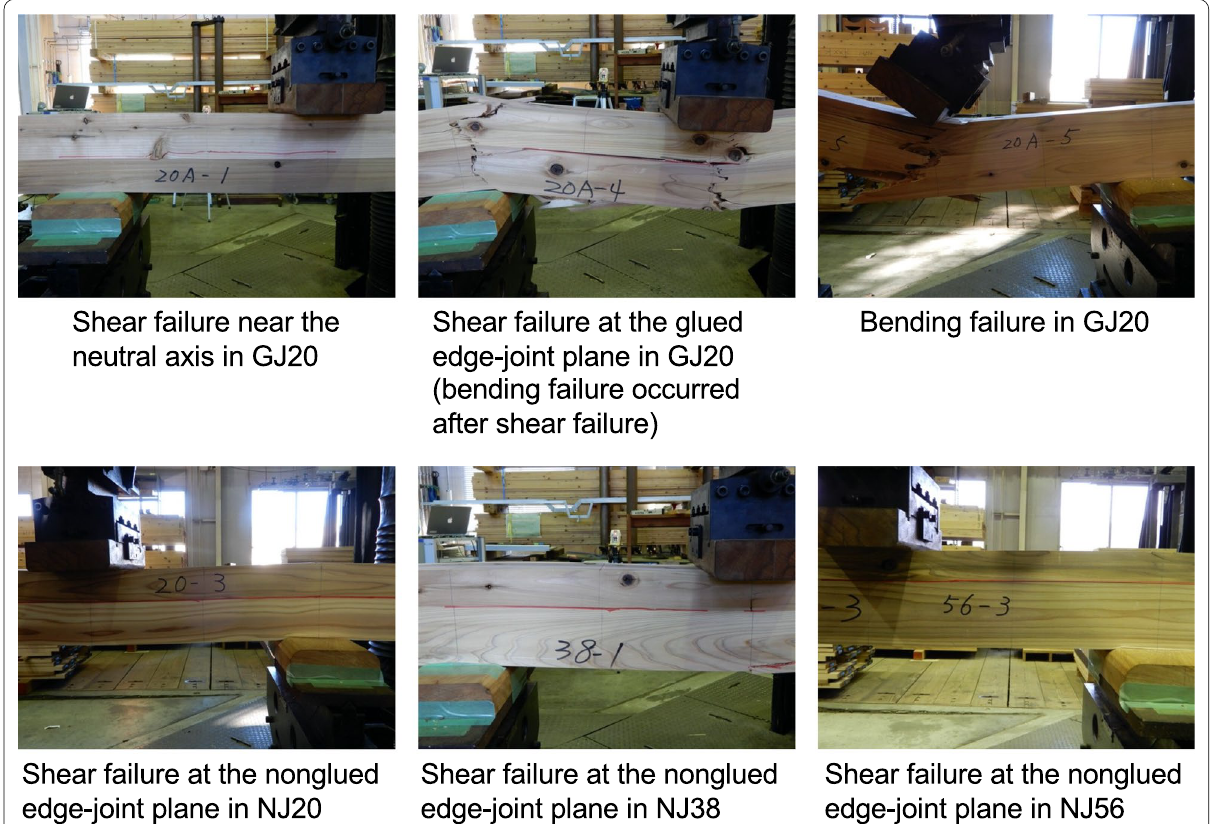
Fig. 6 Examples of the failure modes using the asymmetric four-point bending